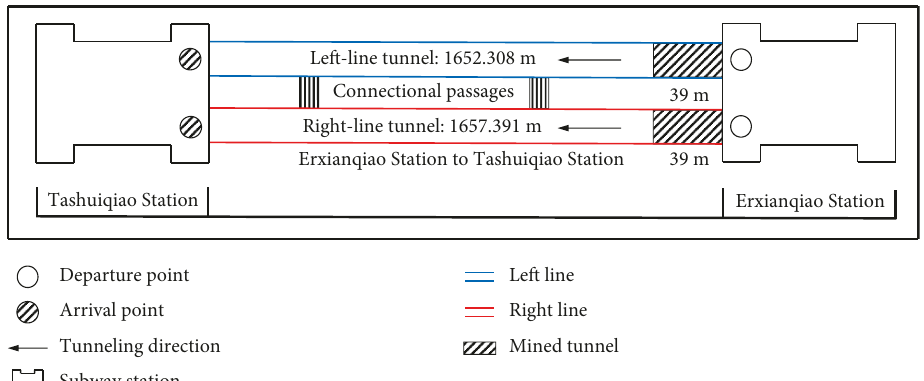
Figure 1: Plane position of the tunnels in the TS-ES